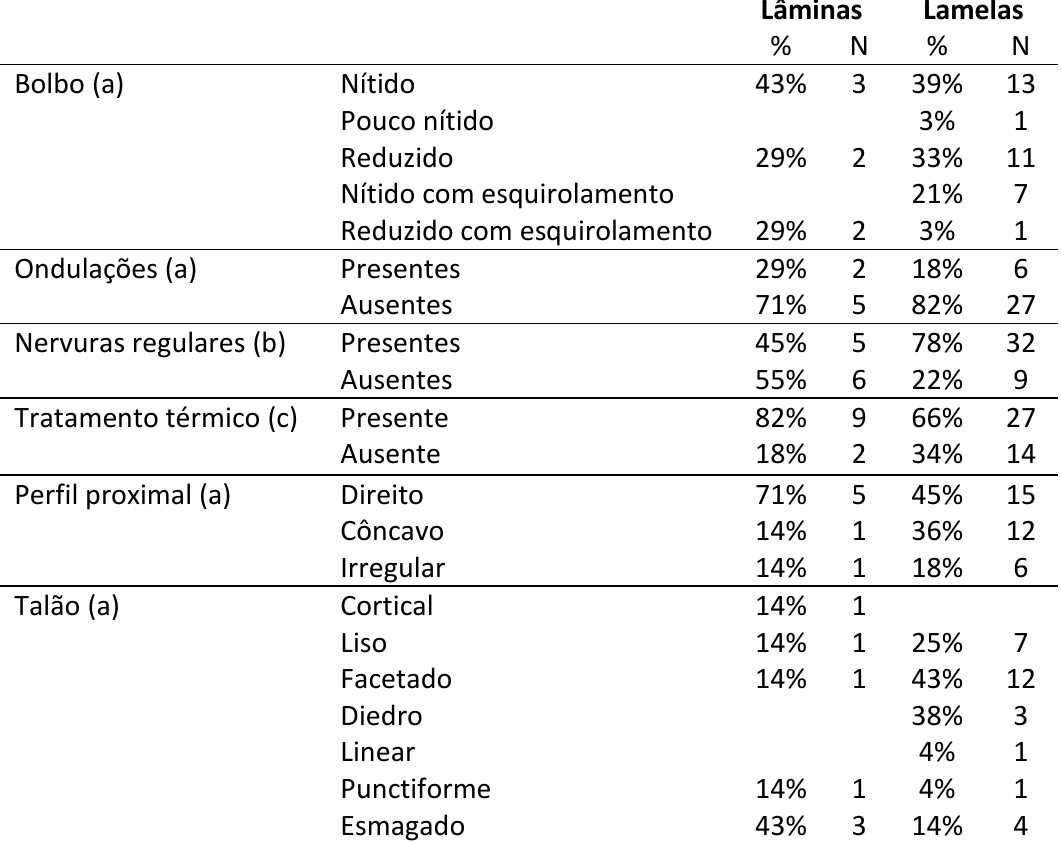
Tabela 5. Atributos específicos do talhe lâmino-lamelar em sílex da Sondagem 3. (a) Peças inteiras e proximais. Table 5. Specific attributes of the blade or bladelet knapping in flint from Test 3. (a) Complete and proximal artifacts. (b) complete and broken artifacts. (c) Only flint